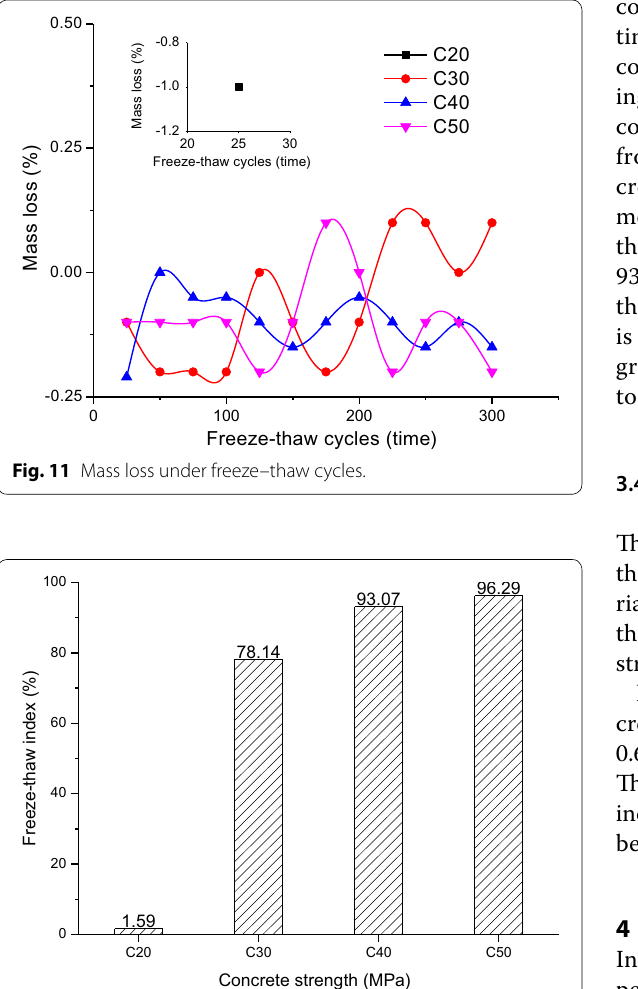
Fig. 12 Freeze–thaw indices of different strengths of concrete.